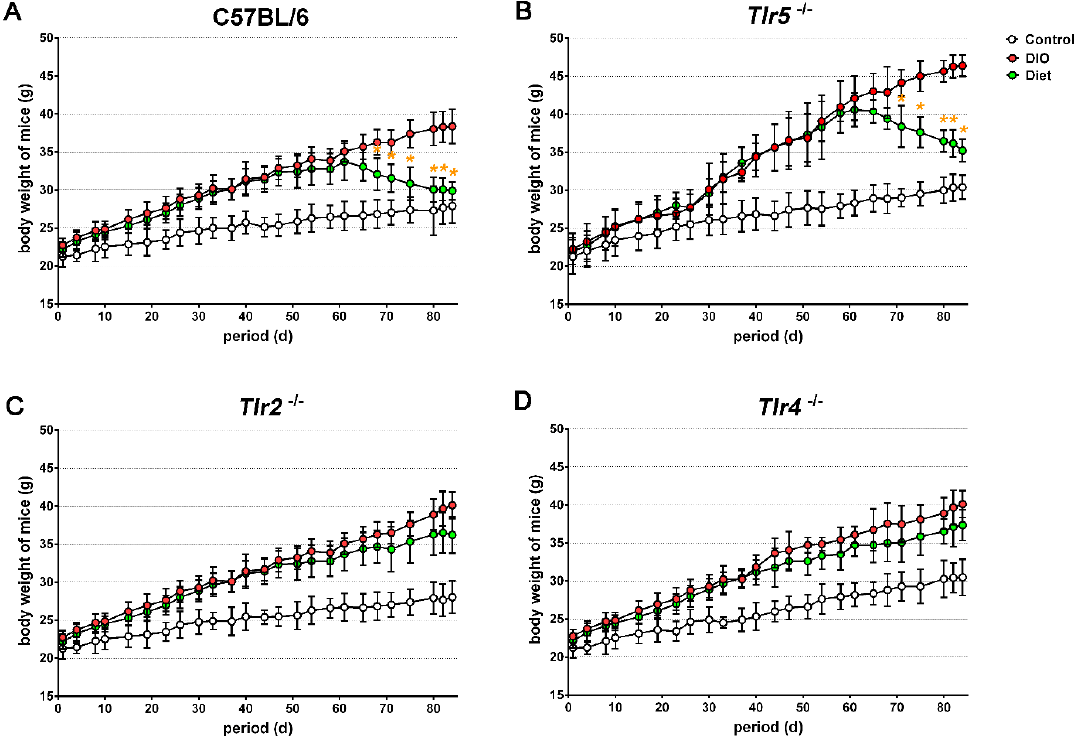
Figure 1. The curve showing the body weights of ( A ) C57BL/6 and ( B – D ) toll–like receptors ( Tlr ) knockout mice grouped as control, diet-induced obesity (DIO), and diet. (yellow color), * p < 0.05 vs. DIO.